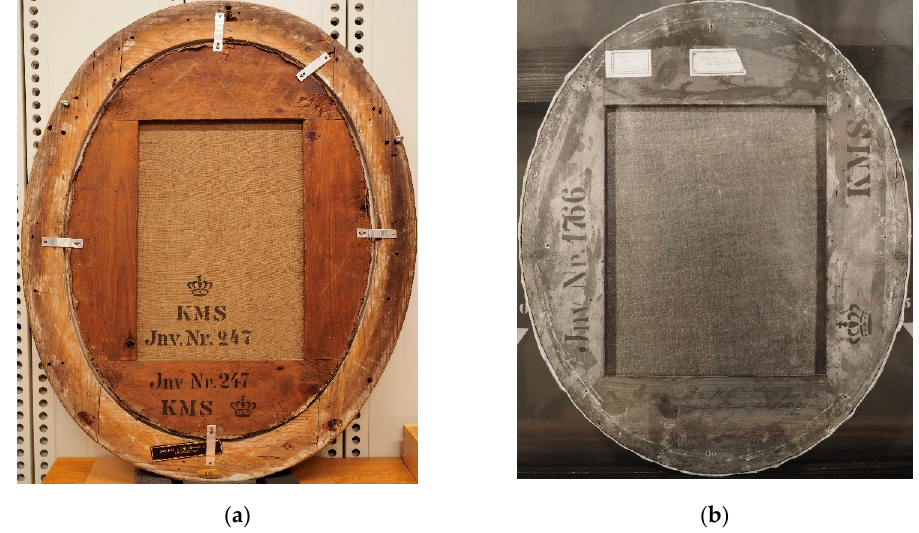
Figure 3. Original oval strainers from the collection of SMK, which is similar to the strainers from Svenstrup Estate: ( a ) the verso of Dameportræt 1790–1799 (KMS247); ( b ) image of the verso of S.E. Holm (KMS1766), before replacement with a modern stretcher. The strainer bears an inscription: “Julie Holm, Professor Jens Juels/ første forlovede, død I sit 22de/Aar/Malet af Jens Juel” (Julie Holm, Professor Juel’s first betrothed, died in her 22nd year, painted by Jens